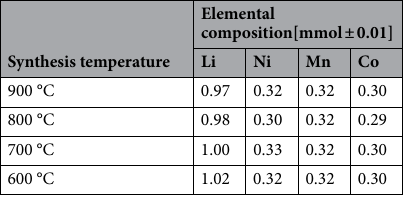
Table 1. ICP-OES results of the four synthesized NMC 111.